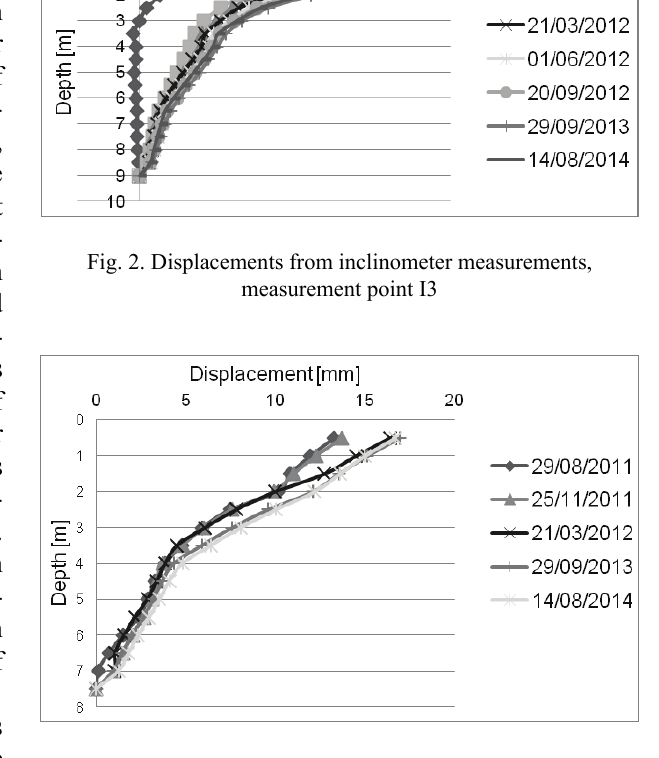
Fig. 3. Displacements from inclinometer